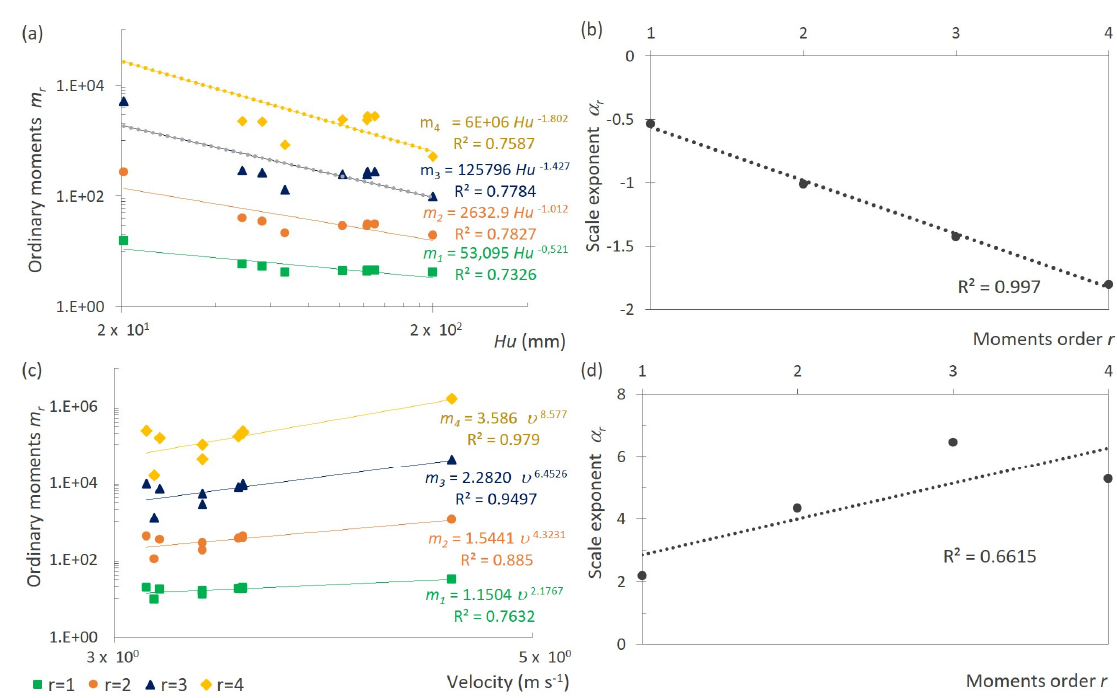
Figure 8. Scalable behavior manifestation of physical vulnerability with respect to ( a ) soil water storage variation in the root zone ( Hu ) and ( c ) stream flow velocity variation ( 𝑣 ). Linearity of scale exponents with ( b ) Hu variation and ( d ) 𝑣 variation.